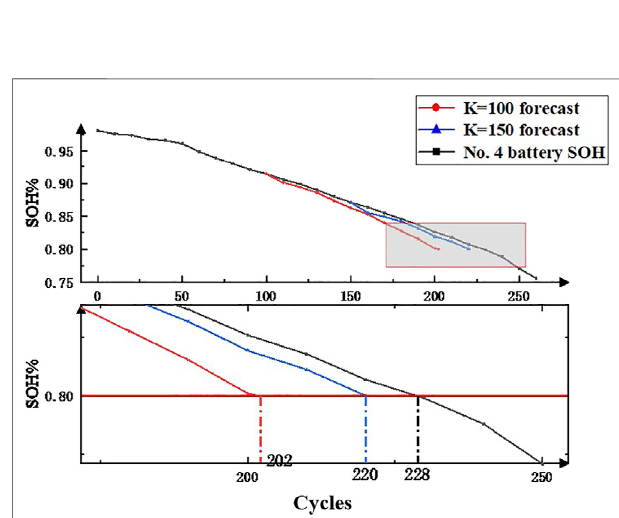
FIGURE 2 | Prediction results of the particle fi lter algorithm for No. 1 battery.